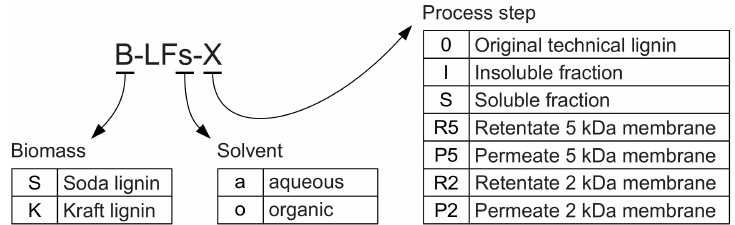
Figure 2. Labelling scheme for lignin